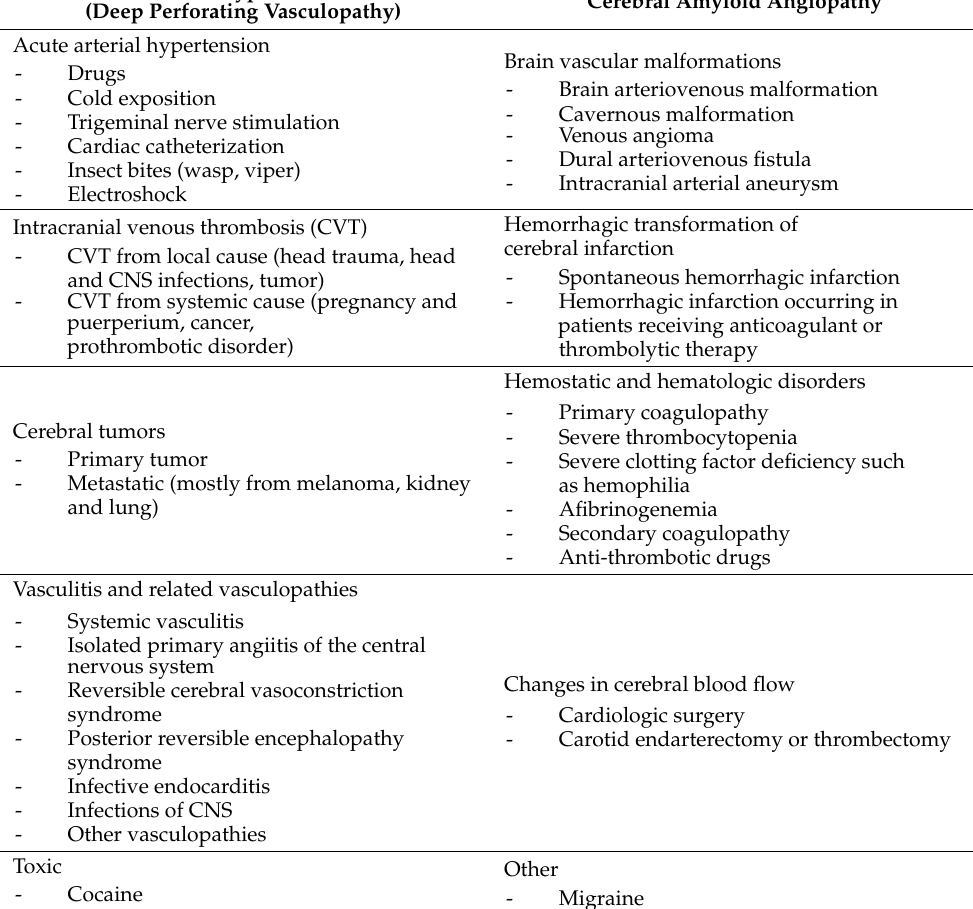
Table 1. Causes of acute spontaneous intracerebral